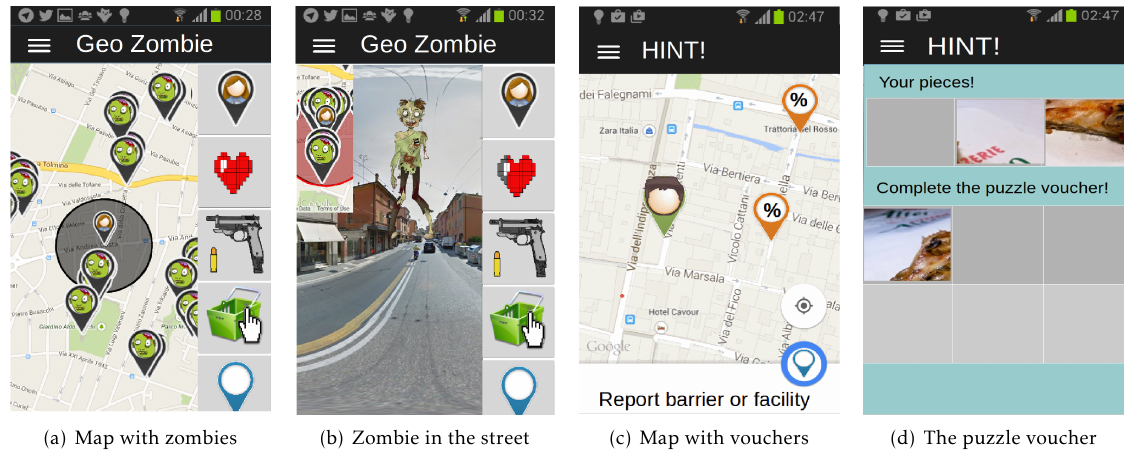
Figure 3. Screenshot of the developed prototype of Geo-Zombie and